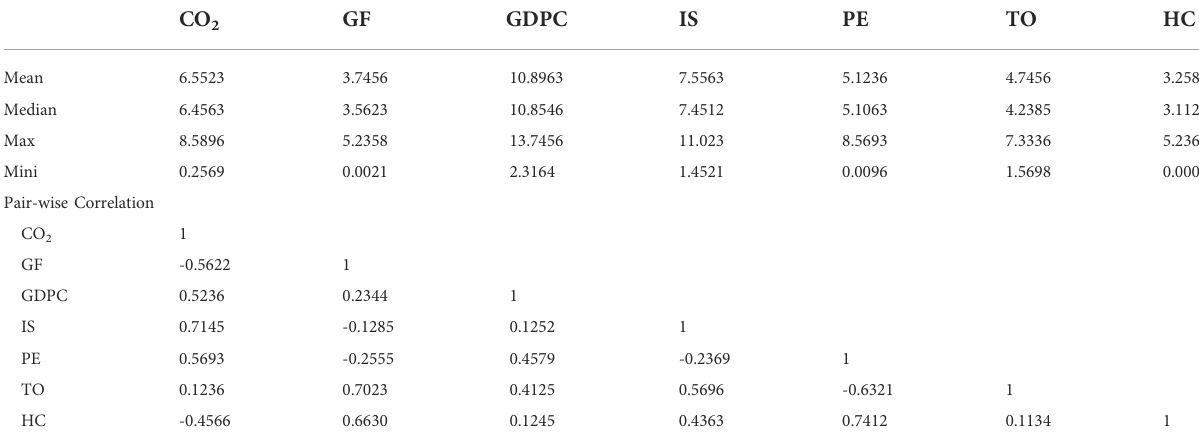
TABLE 2 Descriptive statistics and pair-wise correlation tests.